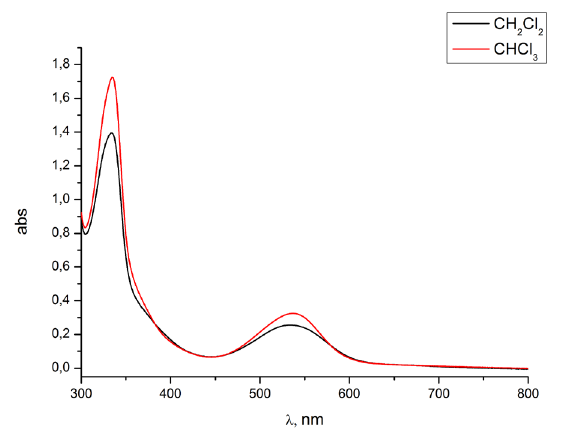
Cl (3.4 ×10 −4 M) and 2 2